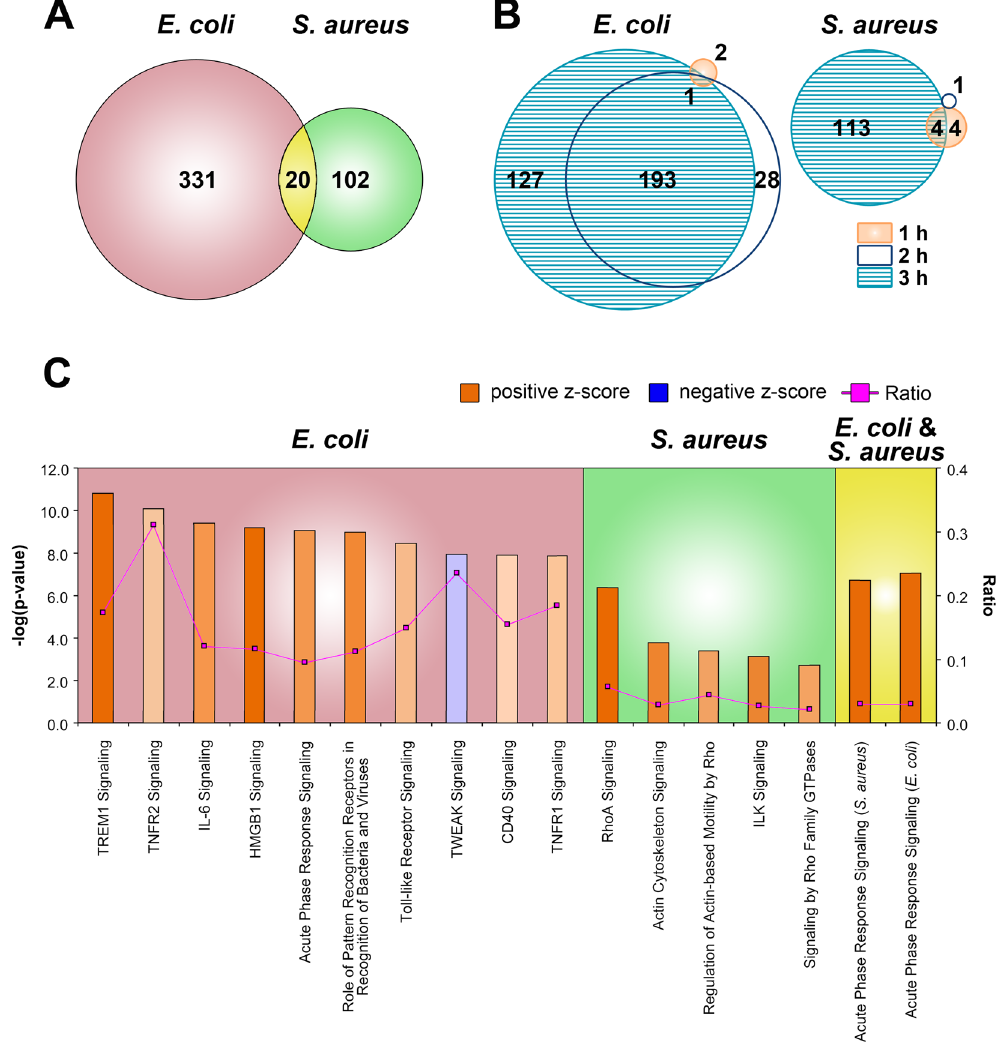
Figure 1. Number and time course of differentially activated genes during E . coli and S . aureus mastitis and their contribution to regulatory pathways. Venn diagrams of ( A ) total number of loci regulated either by E . coli or S . aureus infection and ( B ) number of loci regulated at 1, 2 or 3 h pi during either E . coli or S . aureus infection. ( C ) Ingenuity based identification of key signaling pathways as regulated by either E . coli or S . aureus infection or by both pathogens. The ordinate indicates the logarithm of the statistical significance (p-value). The z-score represents the likelihood that the pathway is regulated (red, up-; blue, down-regulated), with more intense colors reflecting higher significance. Ratio indicates the proportion of DEGs found in the current data set relative to the total number of genes contributing to that